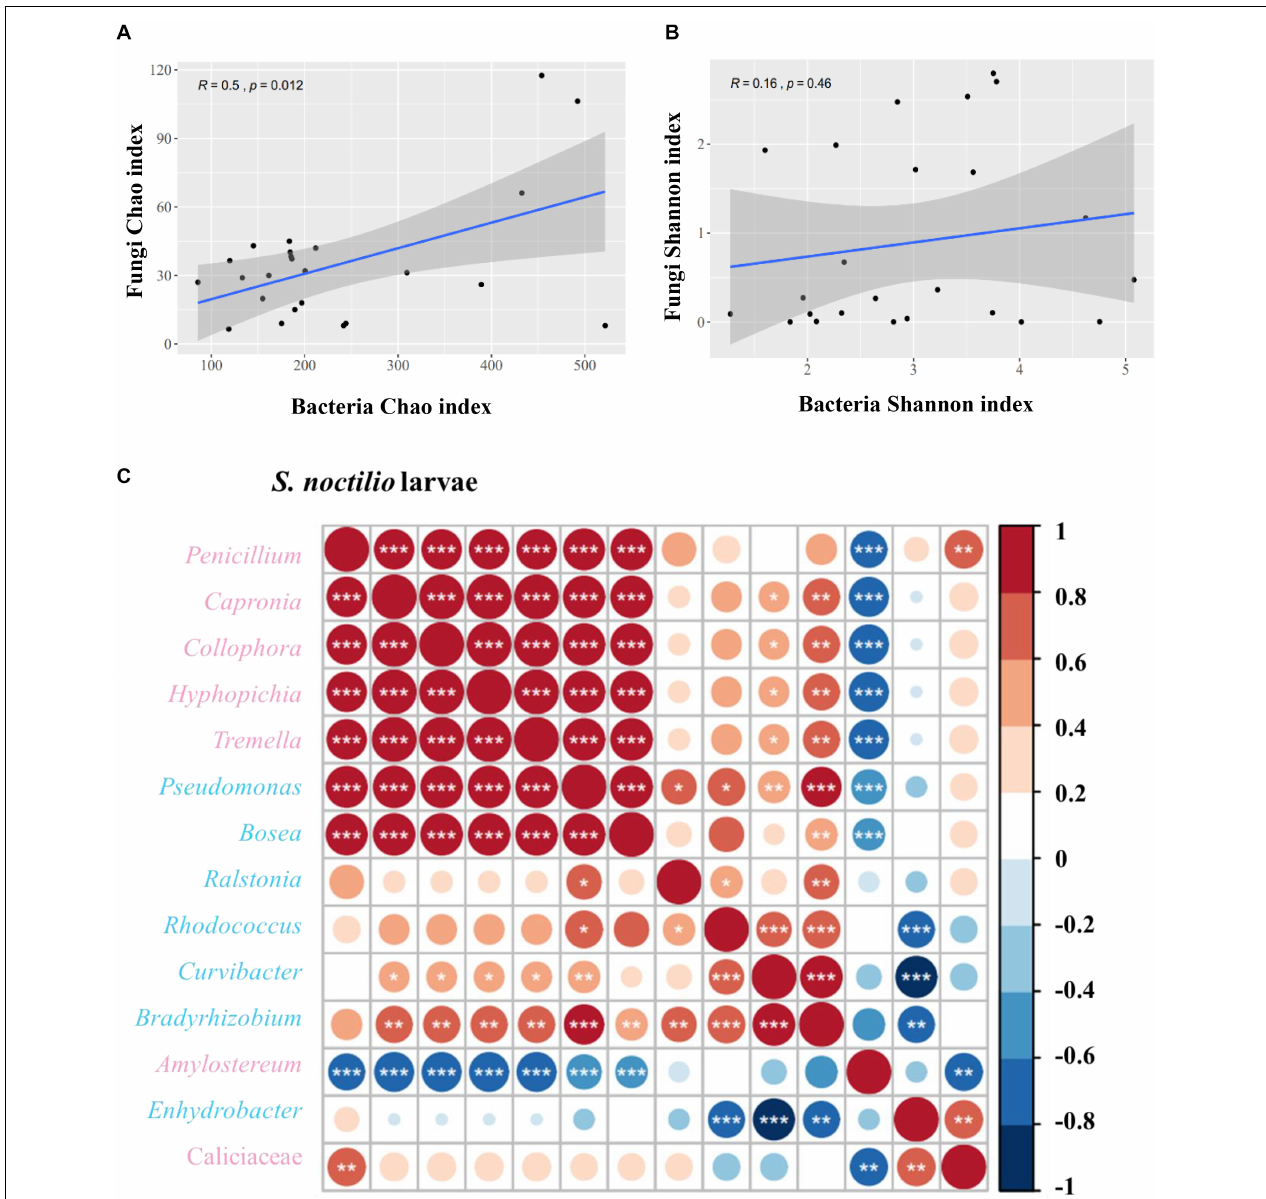
FIGURE 6 | Correlation of bacterial and fungal alpha diversity indices in Sirex noctilio larval gut. (A) Chao index and (B) Shannon index. The Pearson correlation coefficient ( R ) and the significance level ( P -value) are shown on the plots. (C) Spearman correlations of samples with the OTU abundance of bacterial and top seven fungal genera in S. noctilio larval gut. Positive correlations are displayed in red and negative correlations in blue. Color intensity and the size of the circles are proportional to the correlation coefficients. Significant correlations are shown as * P < 0.05, ** P < 0.01, and *** P < 0.001. The pink font indicates fungal genera and light blue font indicates bacterial